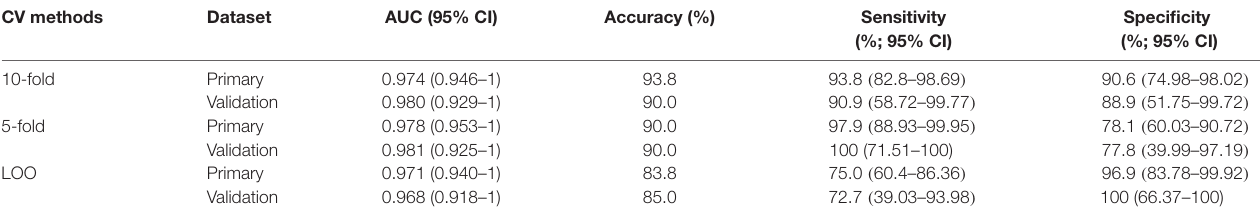
TABLE 3 | Classification performances of the different cross-validation